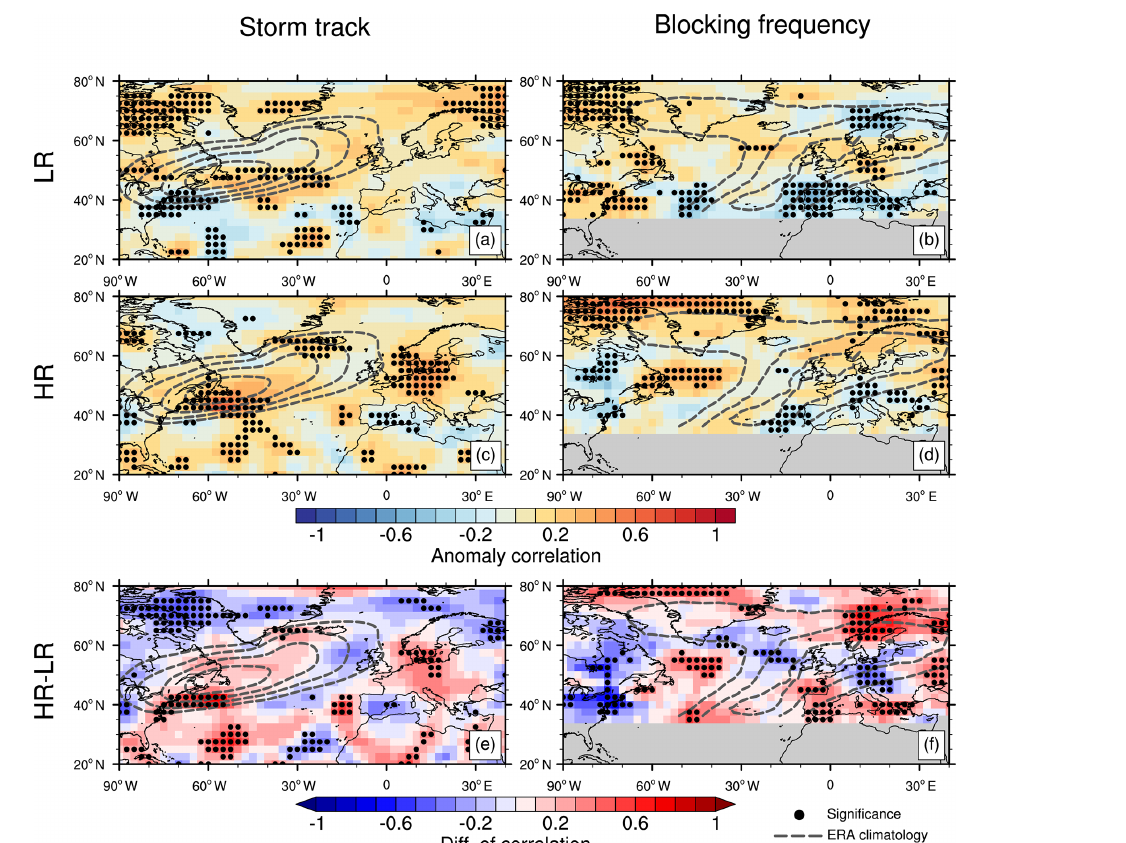
Figure 5. Anomaly correlation between the respective circulation quantity in ERA-Interim and LR (a, b) , between ERA-Interim and HR (c, d) , and the difference between them (e, f) . The circulation quantities displayed are the storm track (a, c, e) and the blocking frequency (b, d, f) . Initializations from the period 1978–2012 are used for both LR and HR, and the correlation is computed for the winter (October–March) average of the hindcast winters 2–5. The dots mark significance (1000 times resampling of reanalysis–hindcast time series) at the 95% significance level. The dashed contours show the climatology of the circulation quantity in ERA-Interim (1979/80 to 2016/17) as depicted